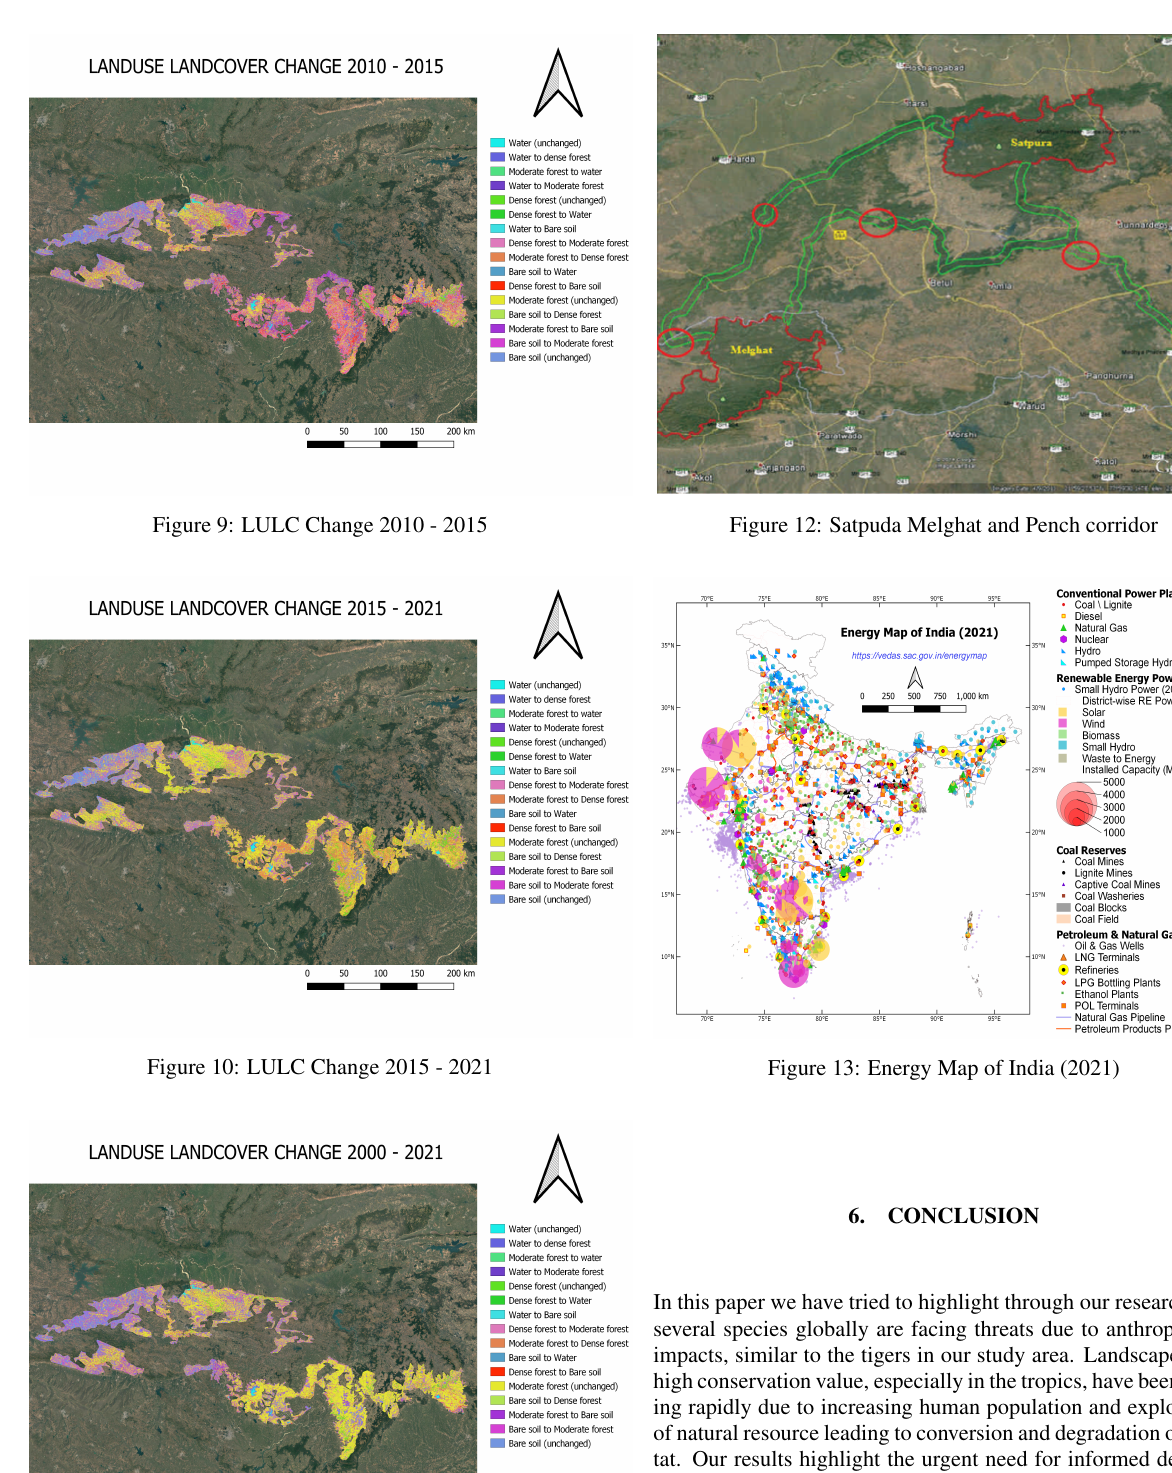
Figure 11: Change Detection LULC 2000 - 2021